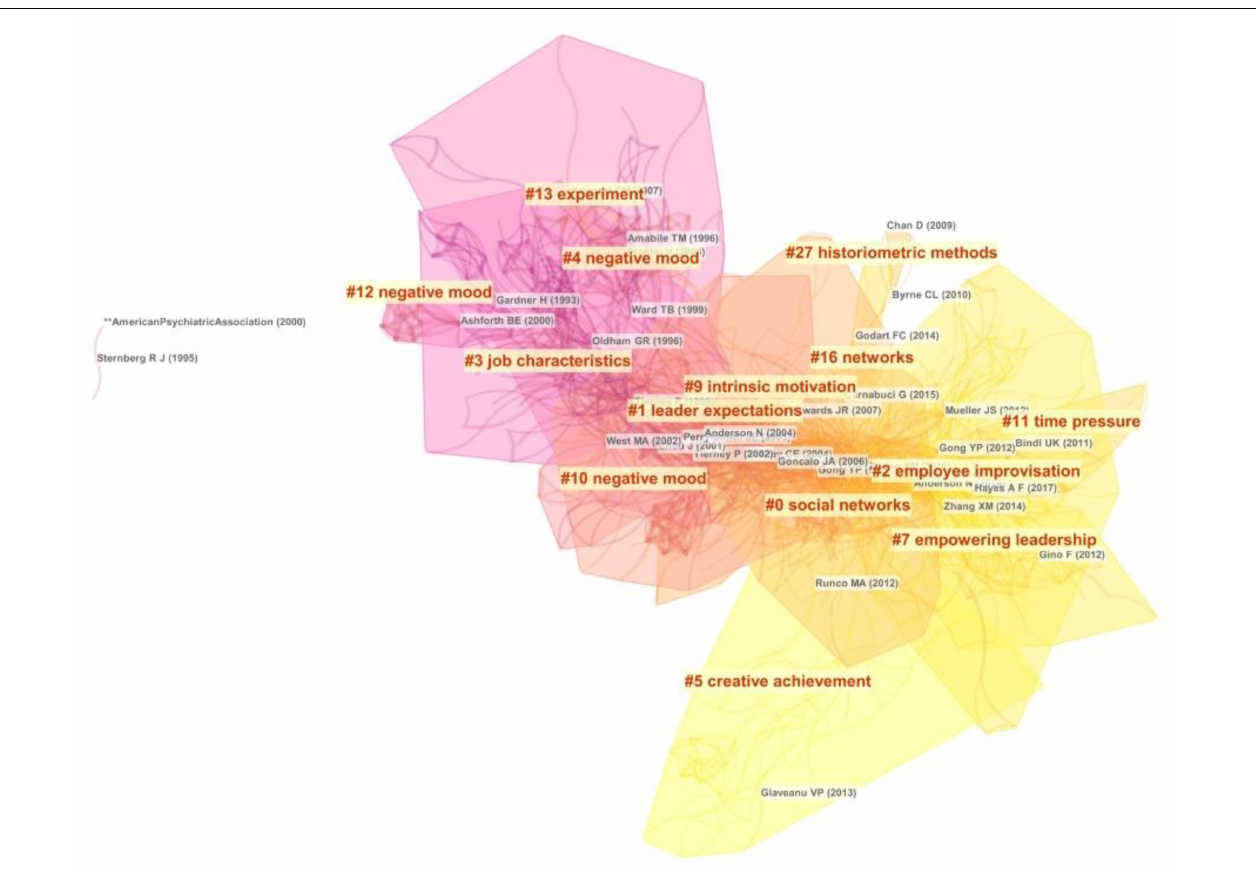
FIGURE 2 | Co-citation knowledge map in 2000–2021.